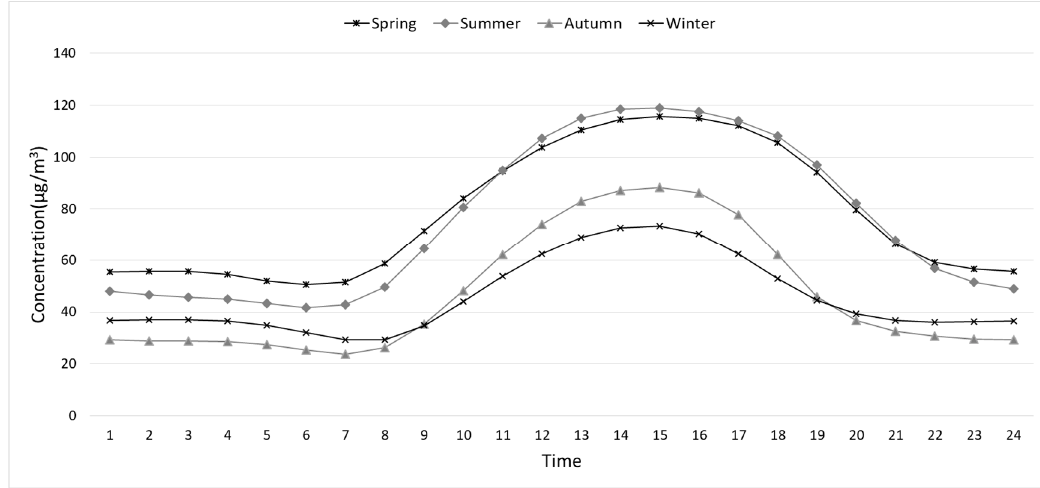
Figure 5. Seasonal O 3 concentration variation of Changchun in 2013–2017.